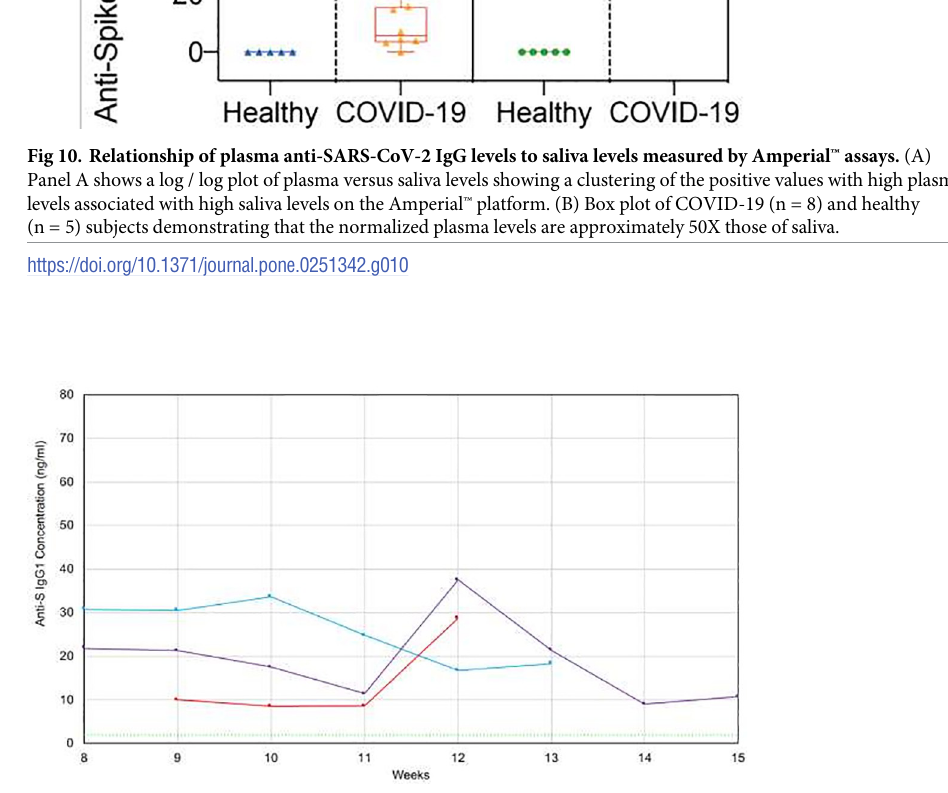
PLOS ONE | https://doi.org/10.1371/journal.pone.0251342 July 1,